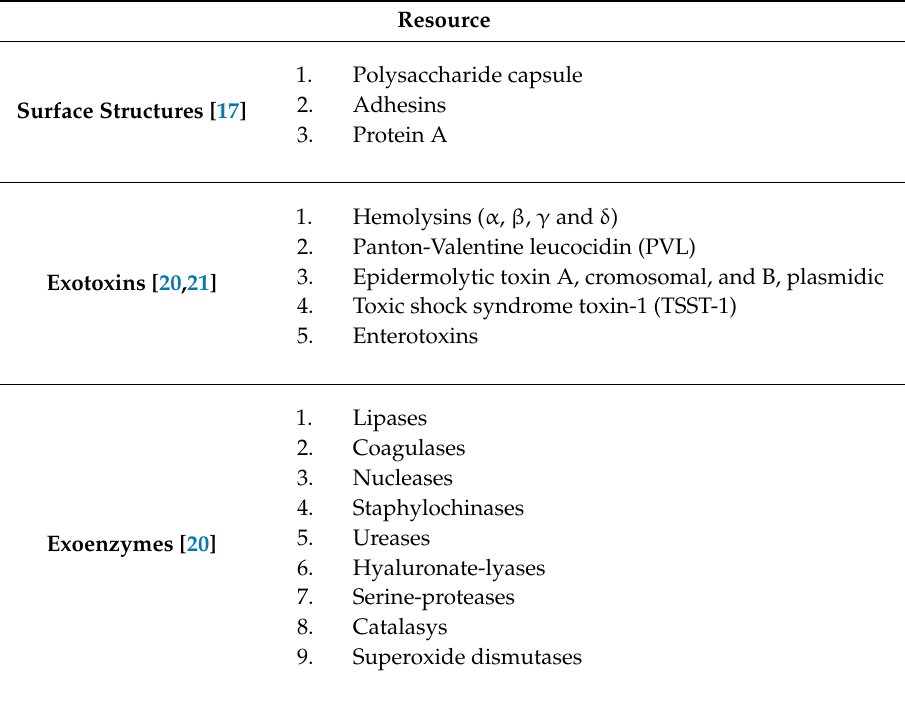
Table 1. Factors conferring virulence to S. aureus .